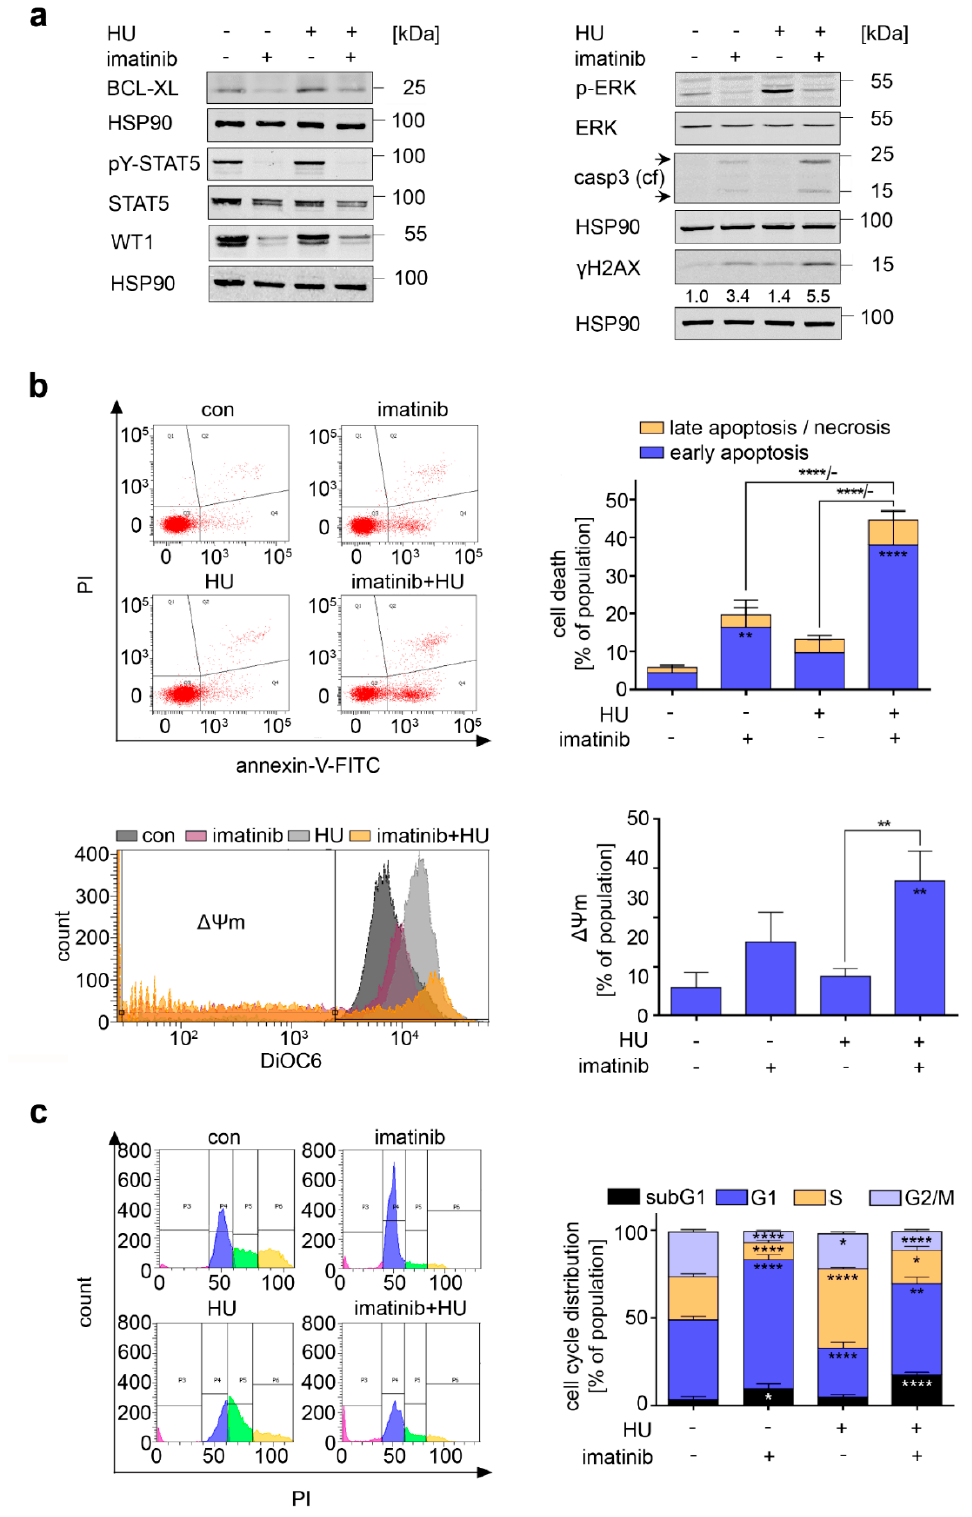
Figure 4. Pro-apoptotic effects of imatinib are more pronounced in cells with replication stress. ( a ) K562 cells were treated with 1 µM imatinib and 1 mM hydroxyurea (HU). Immunoblot analysis shows protein levels of BCL-XL, pY-STAT5, STAT5, WT1, p-ERK, ERK, cleaved caspase-3 (casp3 (cf), caspase-3—cleaved form) and ɣ H2AX.; HSP90 serves as loading control. Arrows indicate the active caspase-3 cleavage products. Numbers below ɣ H2AX blots are densiometric values of the band intensities normalized to the loading control; protein levels of untreated cells are defined as 1.0. ( b ) Upper left: Representative dot plots of K562 cells treated with 1 µM imatinib and 1 mM HU for 24 h. Cells were stained with annexin and PI. Upper right: The induction of apoptosis and necrosis was measured for cells treated as stated before; n = 3 ± SD;